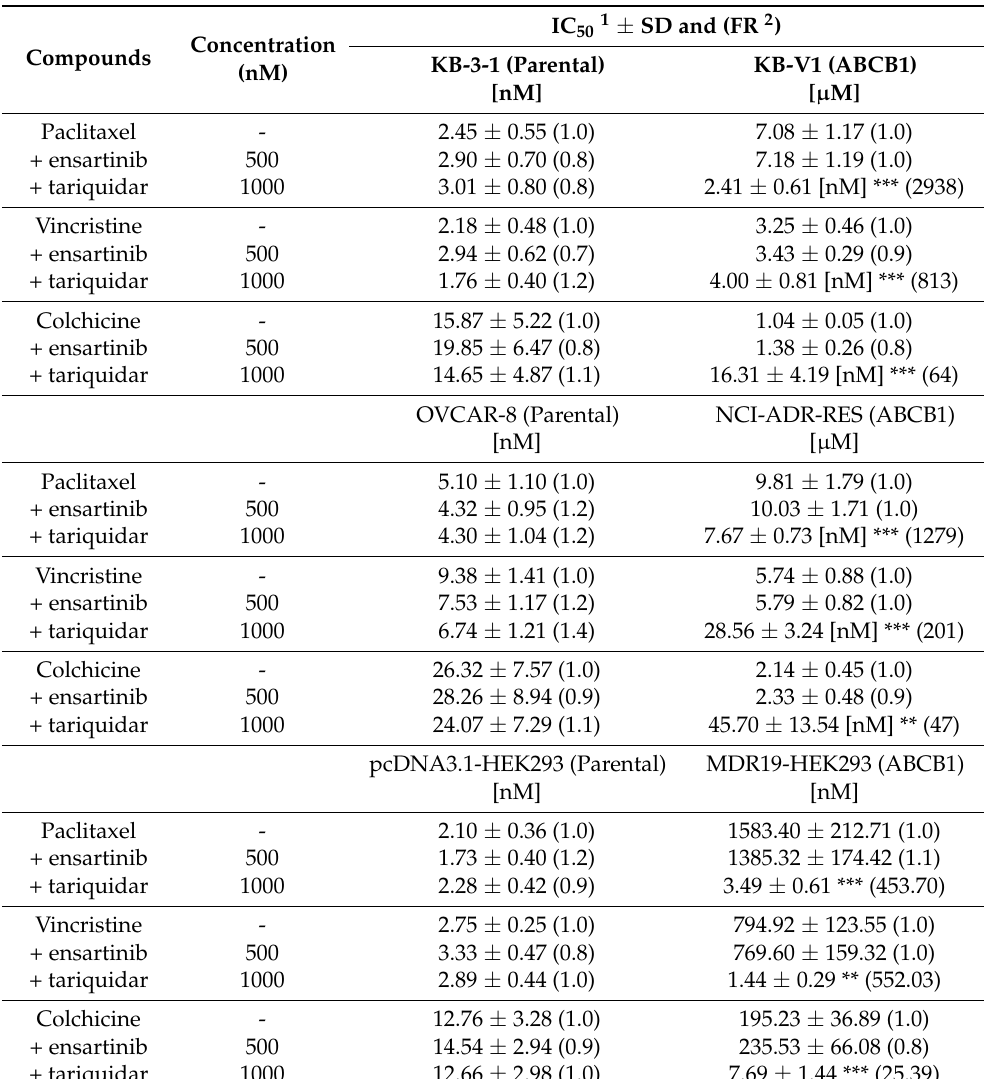
Table 2. Effect of ensartinib on reversing P-gp-mediated multidrug resistance in drug-resistant human cell